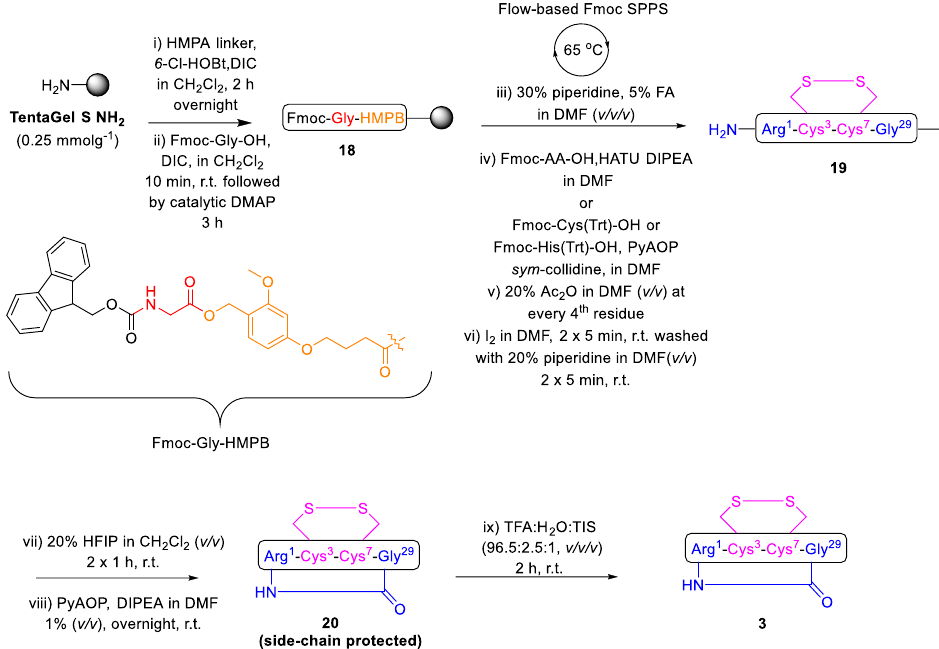
Scheme 5. Synthesis of bicyclic cathelicidin-PY analogue 3 on continuous flow synthesis at 65 °C with a flow rate of 15 mL/min and a resonance time of 40